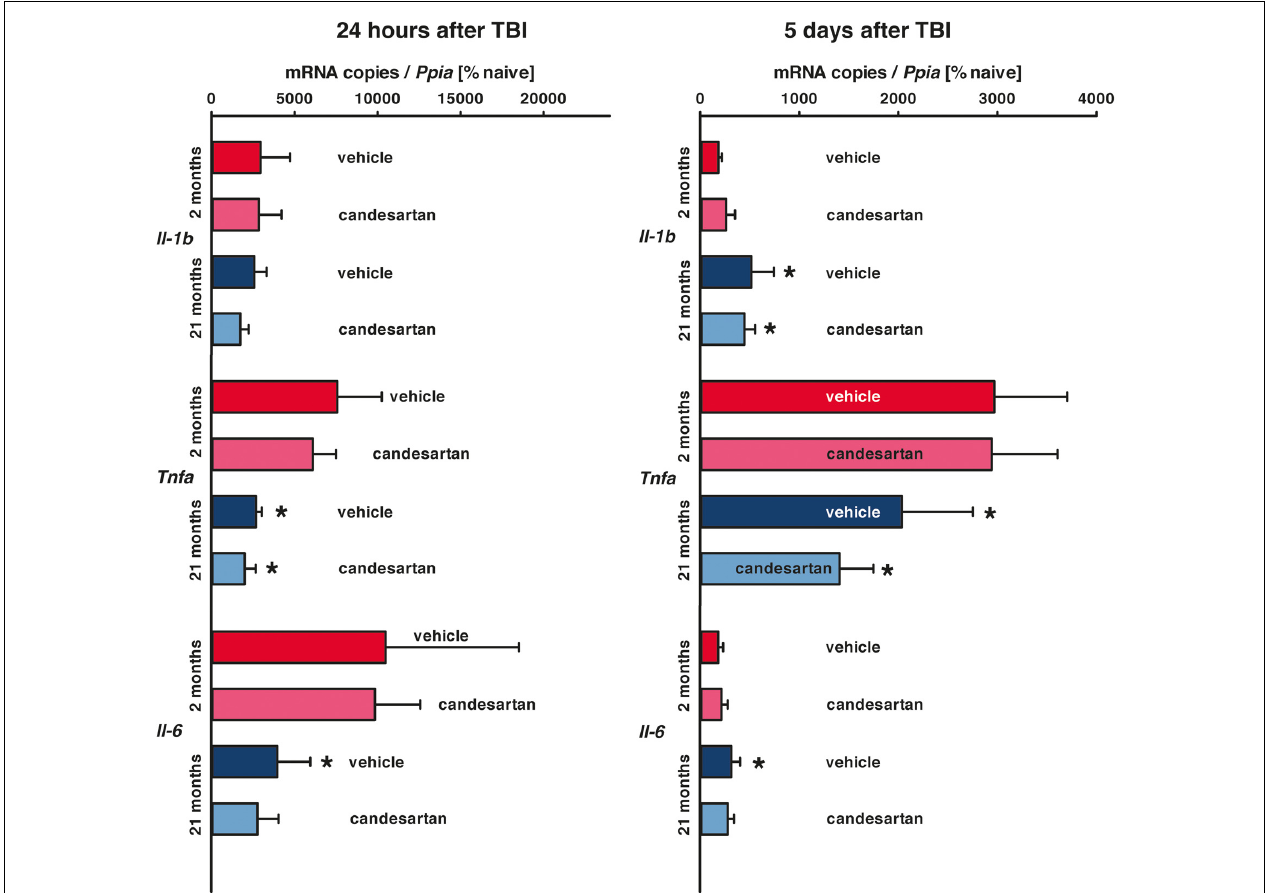
FIGURE 3 | Influence of AT1 inhibition on posttraumatic expression of inflammatory marker genes. Il1b , Il6 and Tnfa mRNA expression levels were quantified in the right hemisphere by qPCR in young and old naïve animals ( n = 6 each), 24 h after insult [candesartan: young ( n = 8); old ( n = 7) or vehicle young ( n = 8); old ( n = 7)], and 5 days after injury [young: vehicle and candesartan ( n = 8 each); old: vehicle ( n = 10; seven survived) and candesartan ( n = 8; seven survived)]. At both time points after TBI, Tnfa expression is increased in young compared to old mice. Whereas expressions of Il1b and Il6 are higher in old mice 5 days after